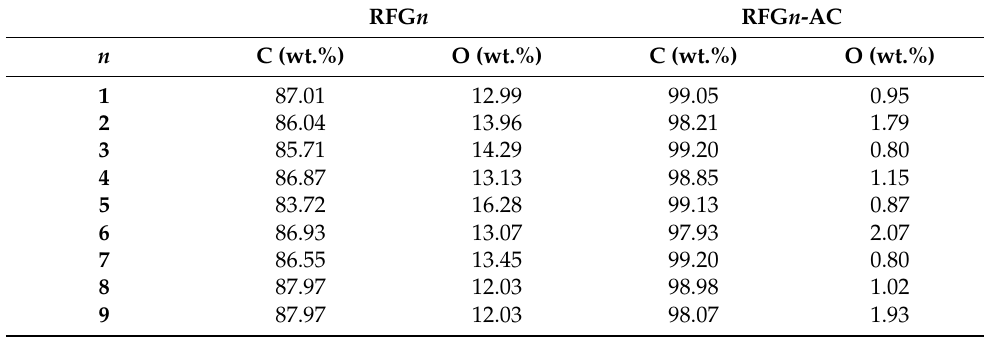
Table 2. EDX atomic analyses of carbon (C) and oxygen (O) in (a) RFG n and (b) RFG n -AC samples.